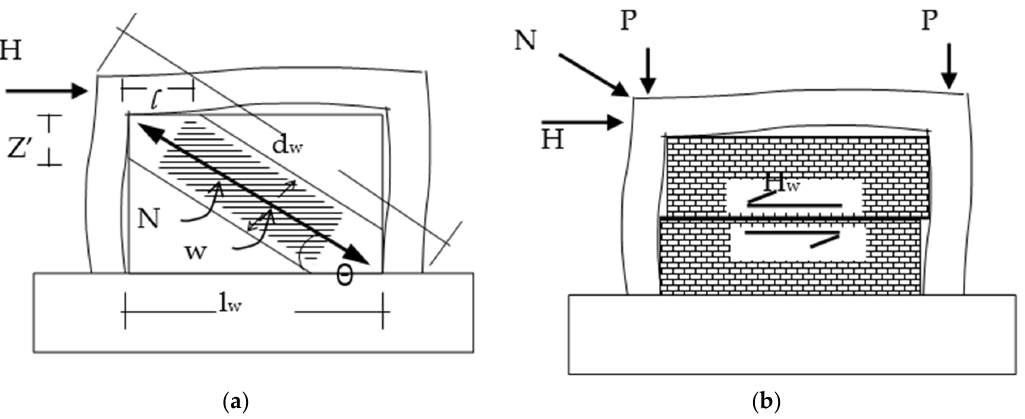
Figure 5. ( a ) UMI as a diagonal strut. ( b ) Shear ‐ sliding failure of UMI.